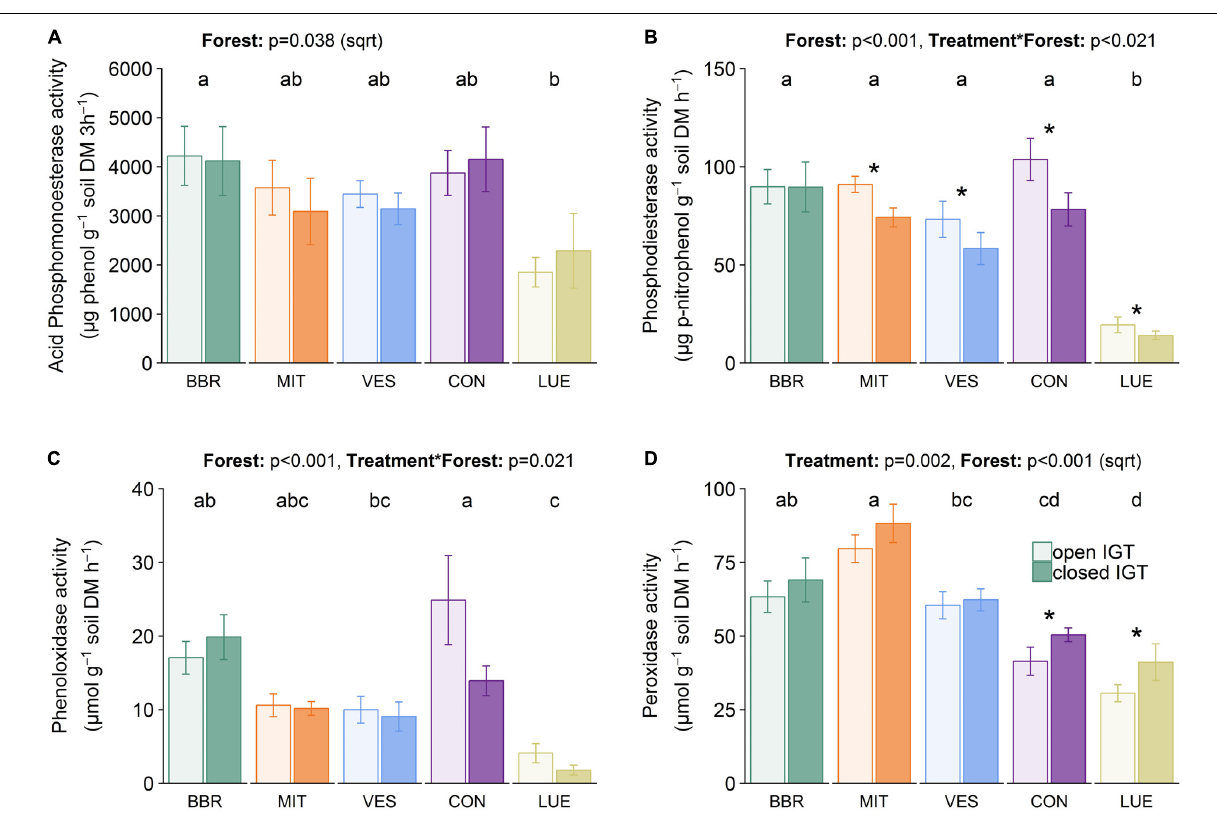
FIGURE 5 | Enzyme activities of (A) acid phosphomonoesterase, (B) phosphodiesterase, (C) phenoloxidase, and (D) peroxidase activity in open and closed IGTs in Bad Brückenau (BBR), Mitterfels (MIT), Vessertal (VES), Conventwald (CON), and Lüss (LUE) after 18 months of exposure ( n = 5). Forests sharing no letter are significantly different and asterisks highlight significant differences between open and closed IGTs at the respective forest